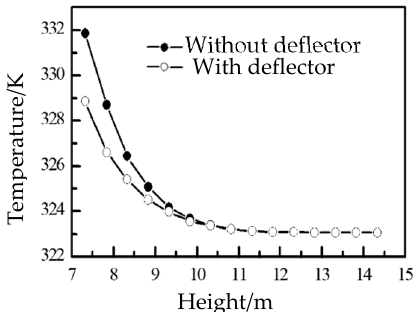
Figure 13. Average temperature of a representative section with and without deflector.